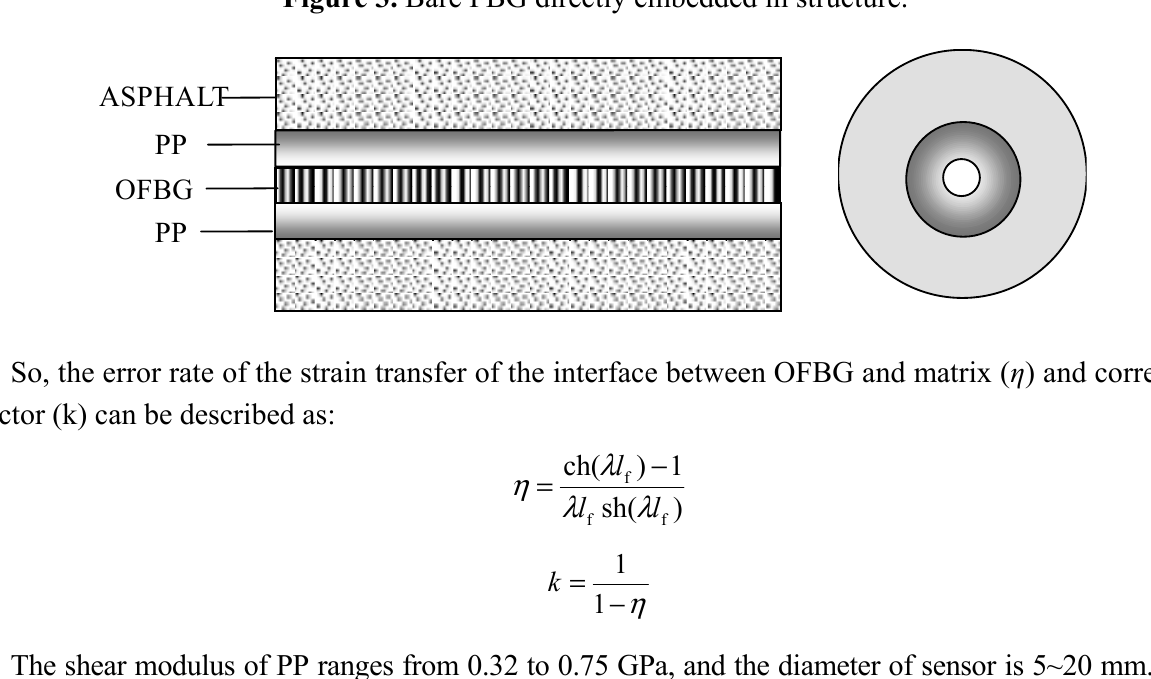
Figure 3. Bare FBG directly embedded in